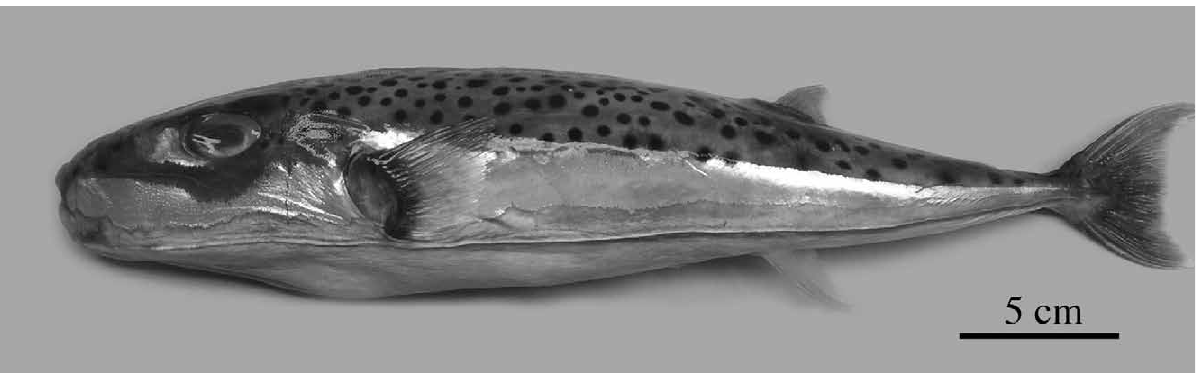
Seriola fasciata . D : VIII, D : I+32, A: II+I+19, 1 2